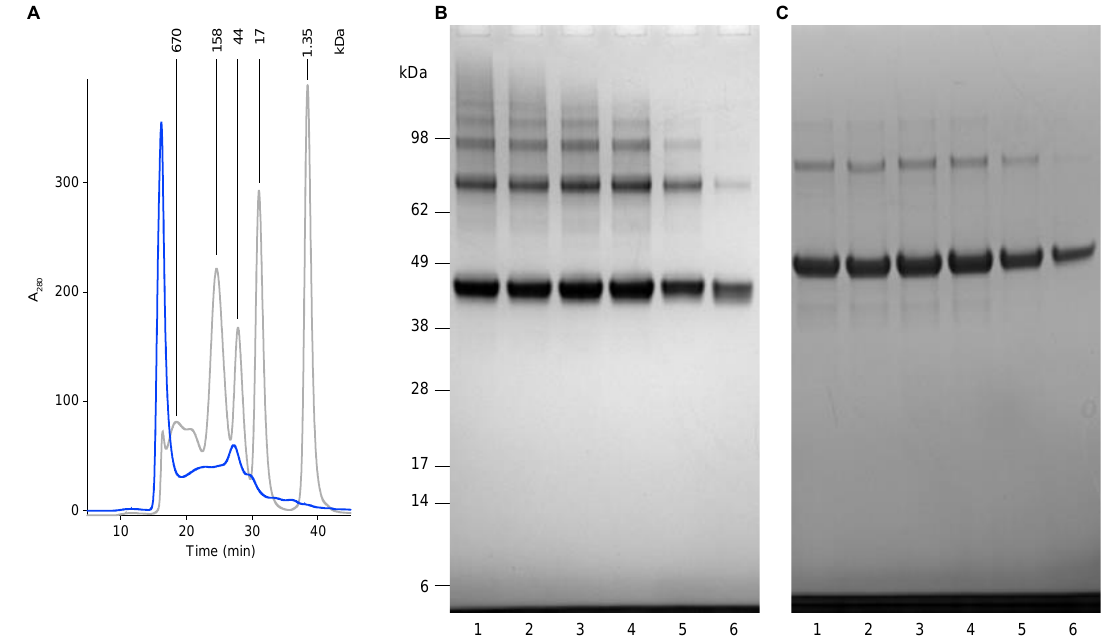
Figure 2. ( A ) Size-exclusion chromatography of USUV E protein fraction after a refolding procedure using rapid dilution (blue line), compared to a mixture of protein markers (grey line) with their molecular mass indicated. ( B ) SDS-PAGE analysis (non-reduced) of collected 1 mL fractions of the SE-chromatography. Lanes 1; fraction 16–18 min; lanes 2, 18–20 min; lanes 3, 20–22 min, lanes 4, 22–24 min, lanes 5, 24–26 min, and lanes 6, 26–28 min. ( C ) SDS-PAGE analysis (non-reduced) of collected 1 mL fractions of the SE-chromatography. Lanes are identical as described for Panel B.